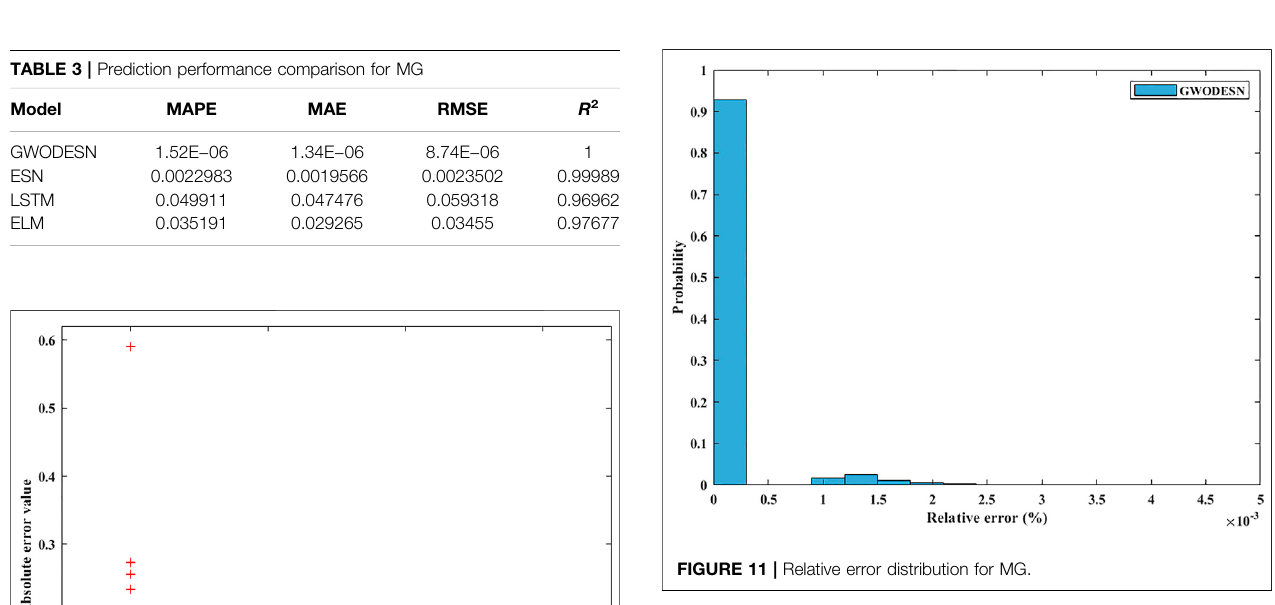
FIGURE 9 | The real value and the anticipated value for MG.